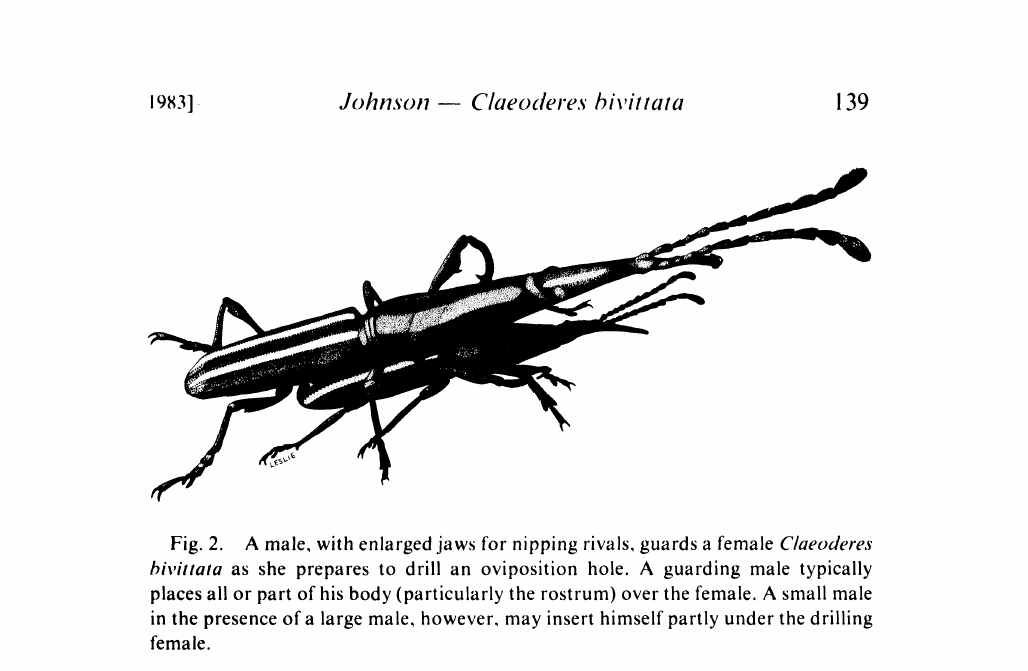
Fig. 2. A male, with enlarged jaws for nipping rivals, guards a female Claeoderes hivittata as she prepares to drill an oviposition hole. A guarding male typically places all or part of his body (particularly the rostrum) over the female. A small male in the presence of a large male, however, may insert himself partly under the drilling